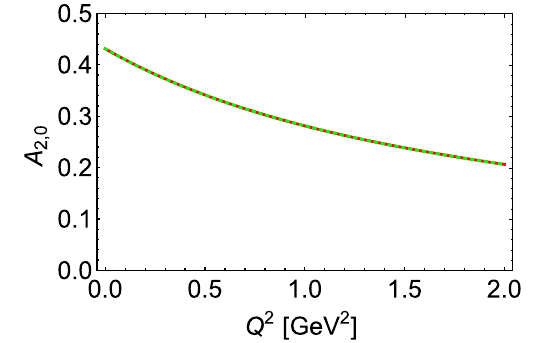
Fig. 12 The quark mass distribution A 2 , 0 from the two different meth- ods: the red solid curve – Eq. (33) from vector GPD, the green dotted curve – Eq. (83) from